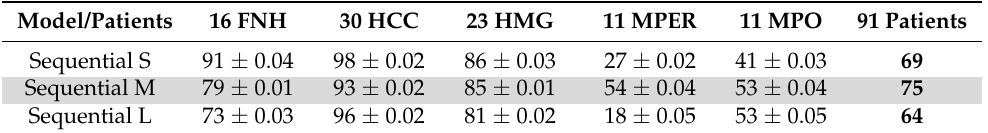
Table 7. Average test accuracy [%] and the corresponding standard deviation. Hard Vote and unbalanced number of examples per